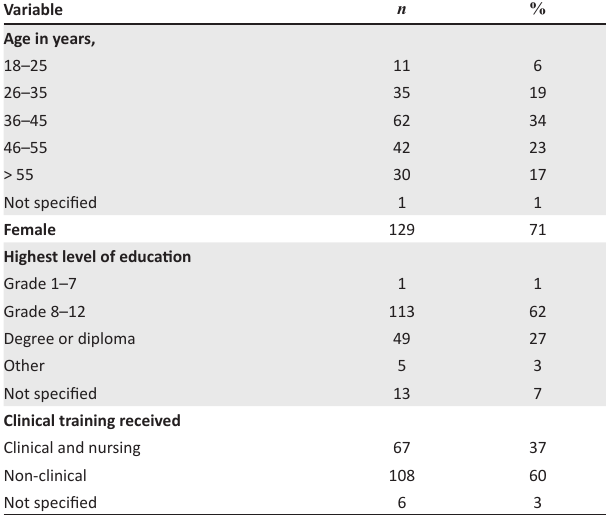
TABLE 1: Demographic profile of